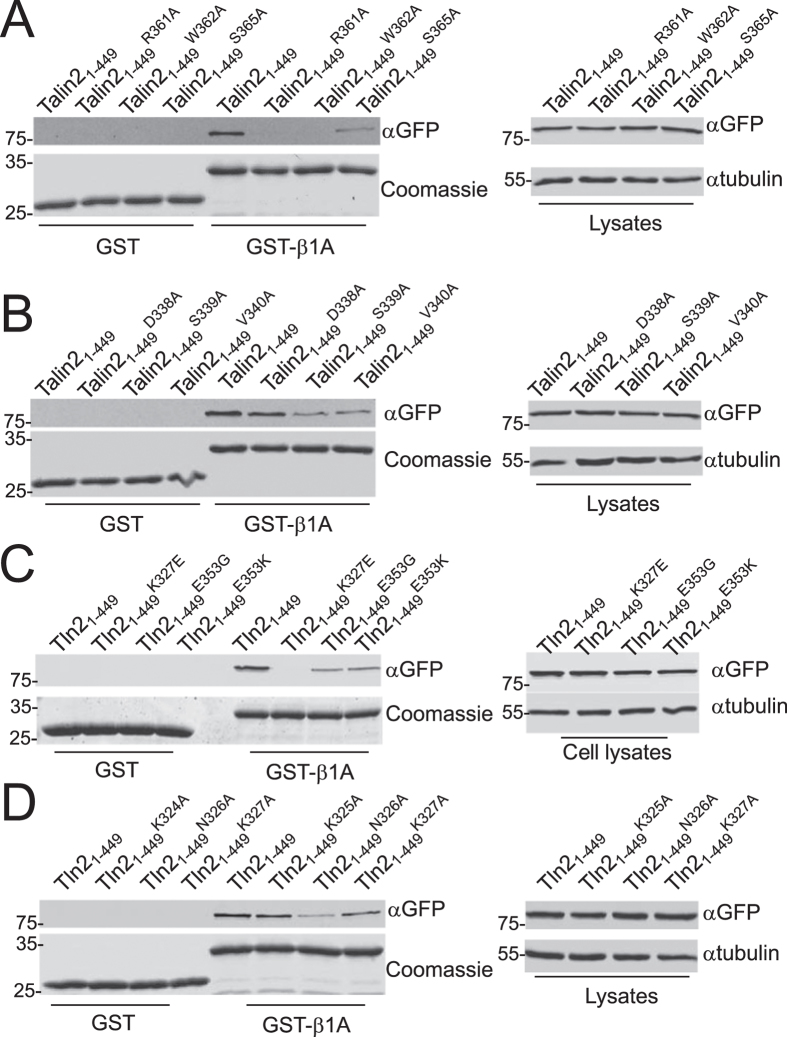
Experimental examination of the computational model.(A) Binding of EGFP-talin21–449WT, -talin21–449R361A, -talin21–449W362A, and -talin21–449S365A to β1-integrin tails by GST pulldown assays. The EGFP fusion proteins were transiently expressed in CHO-K1 cells. (B) EGFP-talin21–449WT, -talin21–449D338A, -talin21–449S339A, and -talin21–449V340A were transiently transfected in to CHO-K1 cells. The binding of these proteins to β1-integrin tails was determined by GST pulldown assays. (C) Binding of EGFP-talin21–449WT, -talin21–449K327E, -talin21–449E353G, and -talin21–449E353K to β1-integrin tails by GST pulldown assays. (D) Binding of EGFP-talin21–449WT, -talin21–449K324A, -talin21–449N326A, and -talin21–449K327A to β1-integrin tails by GST pulldown assays. Cropped blot/gel images are shown. The full-length blot/gel images are included in Supplementary Fig. S4.